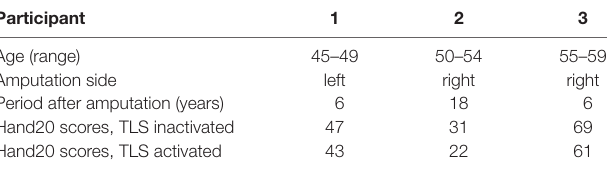
Frontiers in Synaptic Neuroscience |